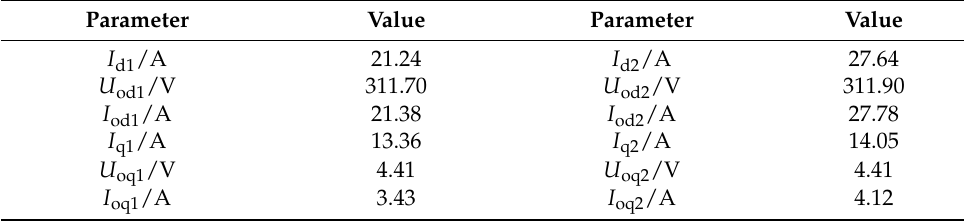
Table 5. Steady-state operating points of the multi-VSG system.